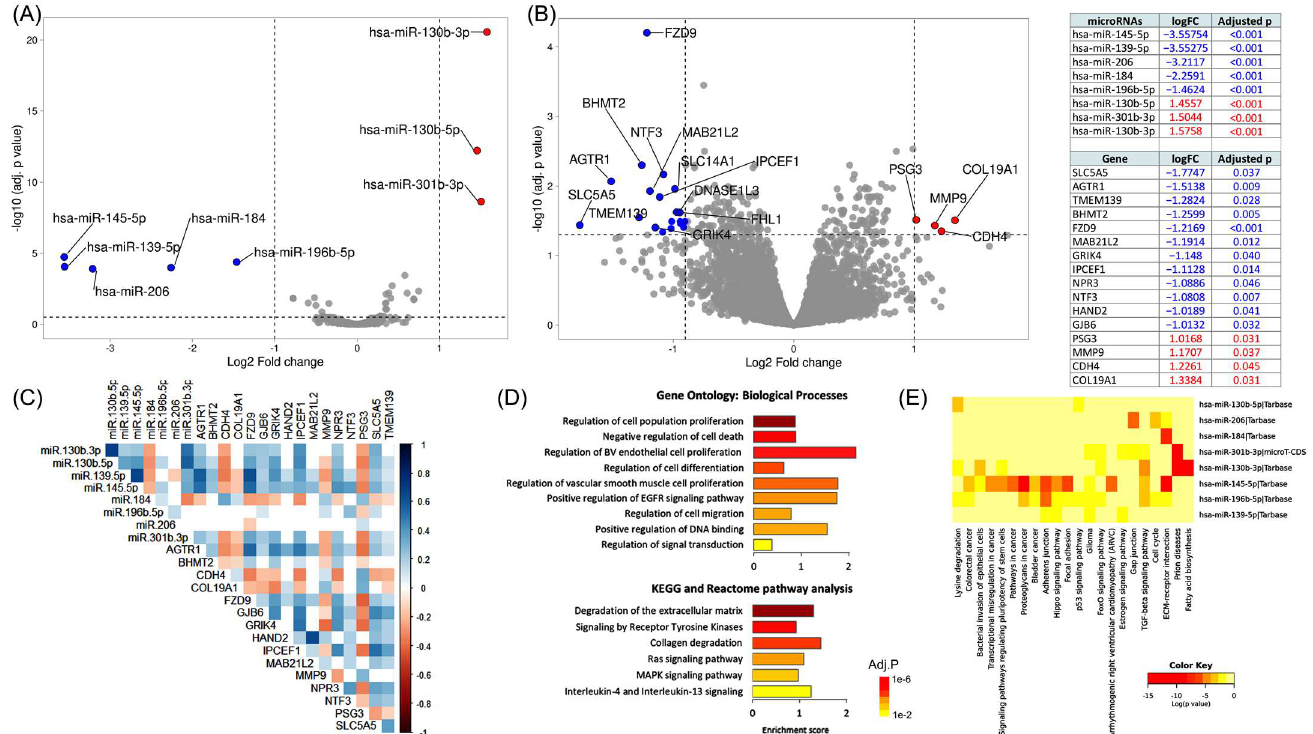
Figure 2. Identification of recurrence-specific differentially expressed genes. RNA-seq and microRNA-seq analysis of 467 tissue specimens of PTC patients in The Cancer Genome Atlas (TCGA) database integrated with clinical data, pathological data, molecular landscape, and survival information. By comparing the transcriptome signature of 46 recurrent and 441 disease-free patients, we identified a panel of eight deregulated microRNAs and 16 deregulated mRNAs associated with disease recurrence and/or progression. ( A ) Volcano plot and table showing differentially expressed microRNAs in recurrent cohorts compared with the non-recurrence group. The significance threshold was set at a false discovery rate (FDR) < 0.05 and a |log2 fold change (logFC)| > 1.0. Three upregulated genes in red and five downregulated genes in blue are shown. ( B ) Volcano plot and table showing differentially expressed mRNAs/lncRNAs in recurrent cohorts compared with the non-recurrence group. Four upregulated genes in red and 12 downregulated genes in blue are shown. ( C ) Co-expression analysis of genes and miRNAs. Spearman’s correlation analysis was performed. In the correlation matrix, red color shows a positive correlation and blue shows a negative correlation. ( D ) Functional enrichment analysis of DEGs. ( E ) Pathway enrichment analysis of DEmiRs using Diana lab